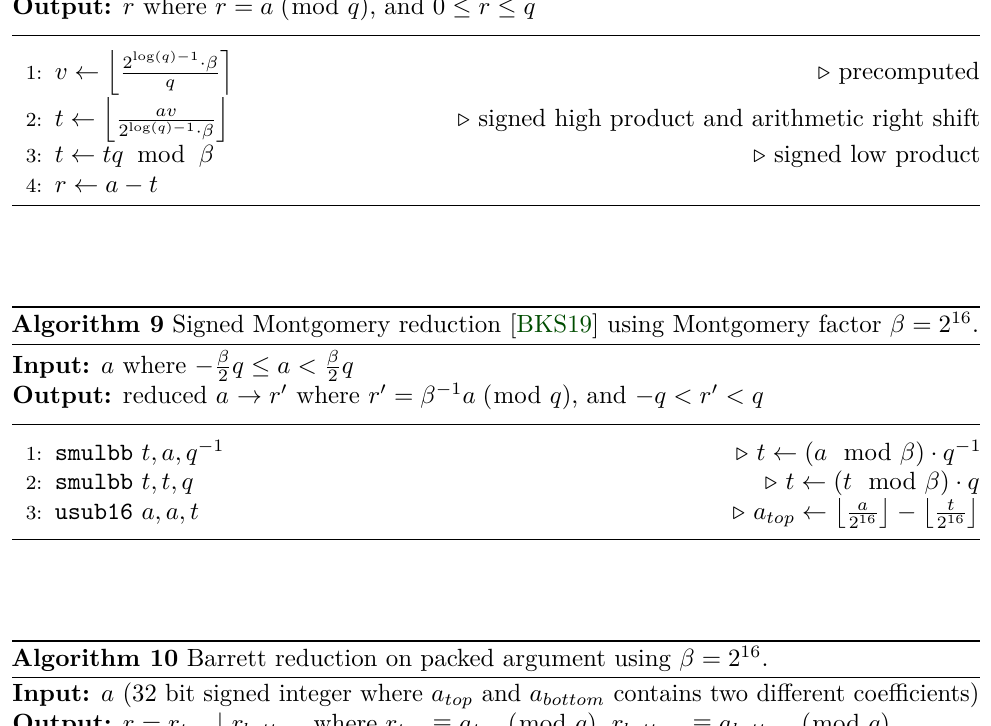
Algorithm 10 Barrett reduction on packed argument using β = 2 16